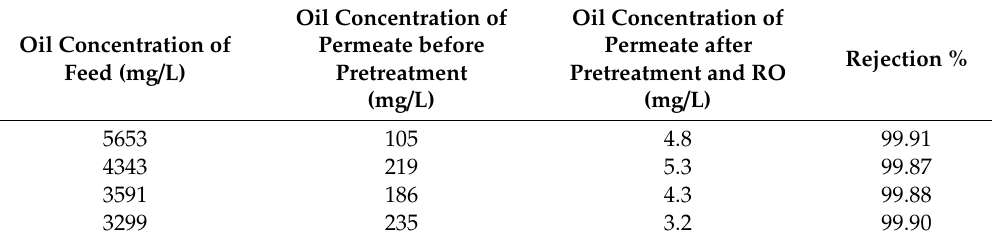
Table 4. E ff ect of pretreatment on permeate